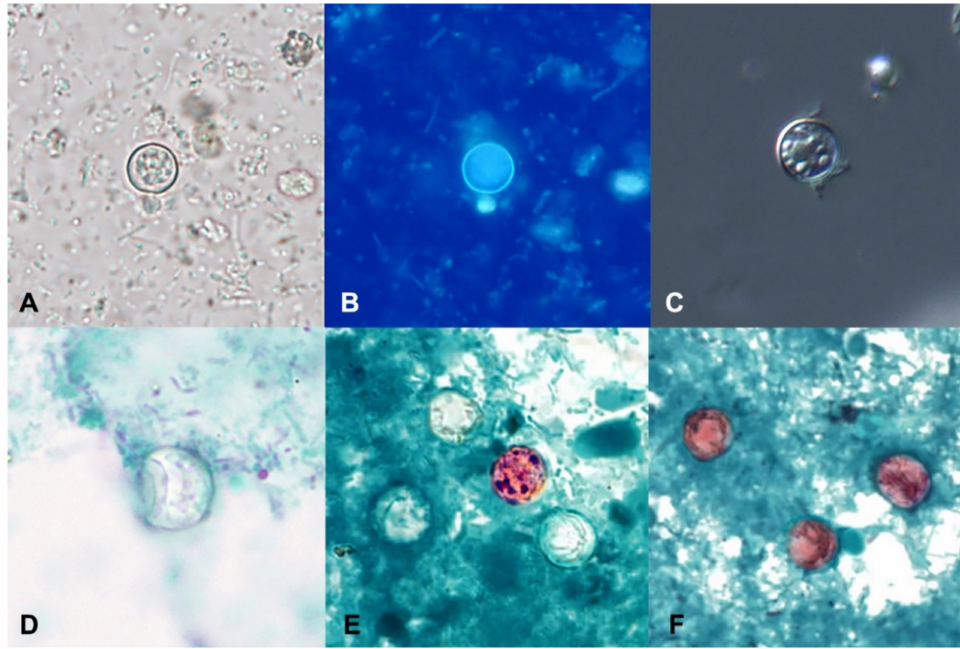
Figure 2. Oocysts of Cyclospora cayetanensis in stool specimens observed under different staining methods. ( A ) unstained concentrated wet mount. ( B ) UV autofluorescence. ( C ) differential interfer- ence contrast (DIC). ( D ) trichrome stain. ( E ) Kinyoun’s modified acid-fast. ( F ) modified safranin. (Figures courtesy of the